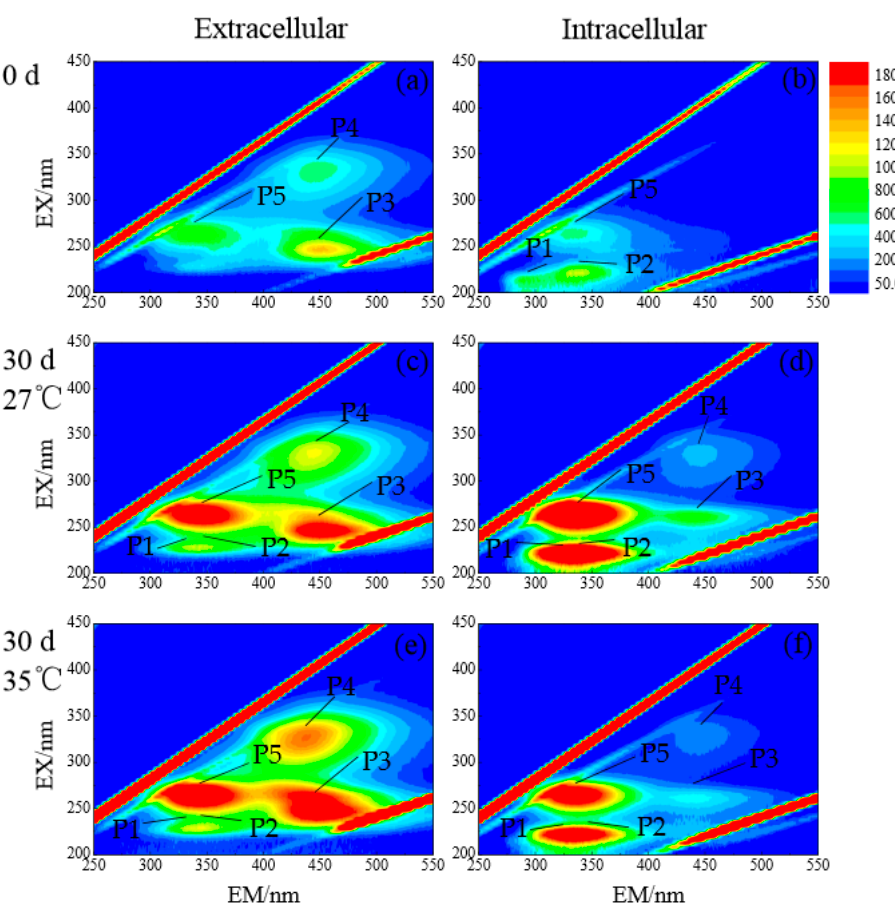
Figure 5. EEMs of Dolichospermum spiroides at two different temperatures: ( a , b ) EEMs of extra- and intracellular DOMs in the beginning of the culture; ( c , d ) EEMs of extra- and intracellular DOMs on the 30th day of the culture at 27 °C; ( e , f ) EEMs of extra- and intracellular DOMs on the 30th day of the culture at 35 °C. P1 represents the peak fluorescence intensity (FI) value of tryptophan aromatic protein; P2 represents the peak FI value of tyrosine aromatic protein; P3 represents the peak FI value of fulvic acid; P4 represents the peak FI value of humic acid; P5 represents the peak FI value of the soluble microbial metabolites.